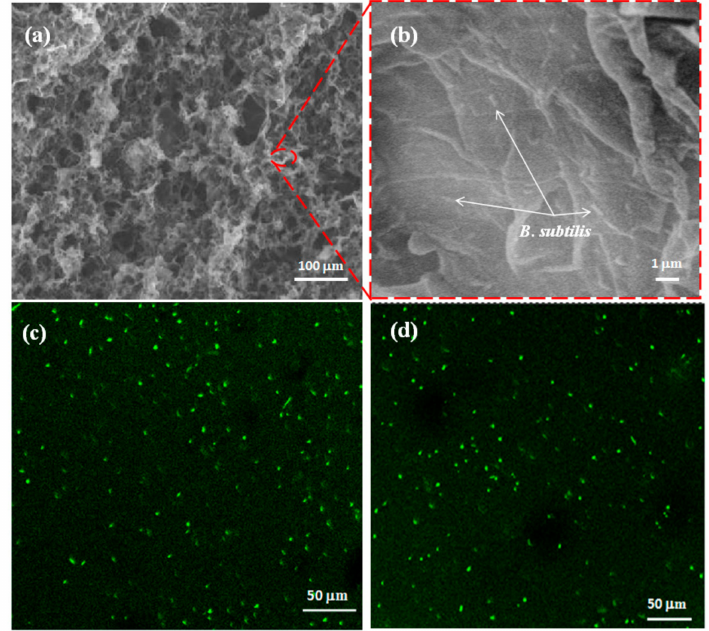
Figure 7. SEM and confocal laser scanning microscopy (CLSM) images of rGO-PPy- B microbial biofilm. ( a ) Typical SEM image of the interior microstructure of rGO-PPy- B microbial biofilm; ( b ) the magnified SEM image of ( a ); CLSM images of rGO-PPy- B microbial biofilm collected at the surface ( c ) and 6 mm depth ( d ).